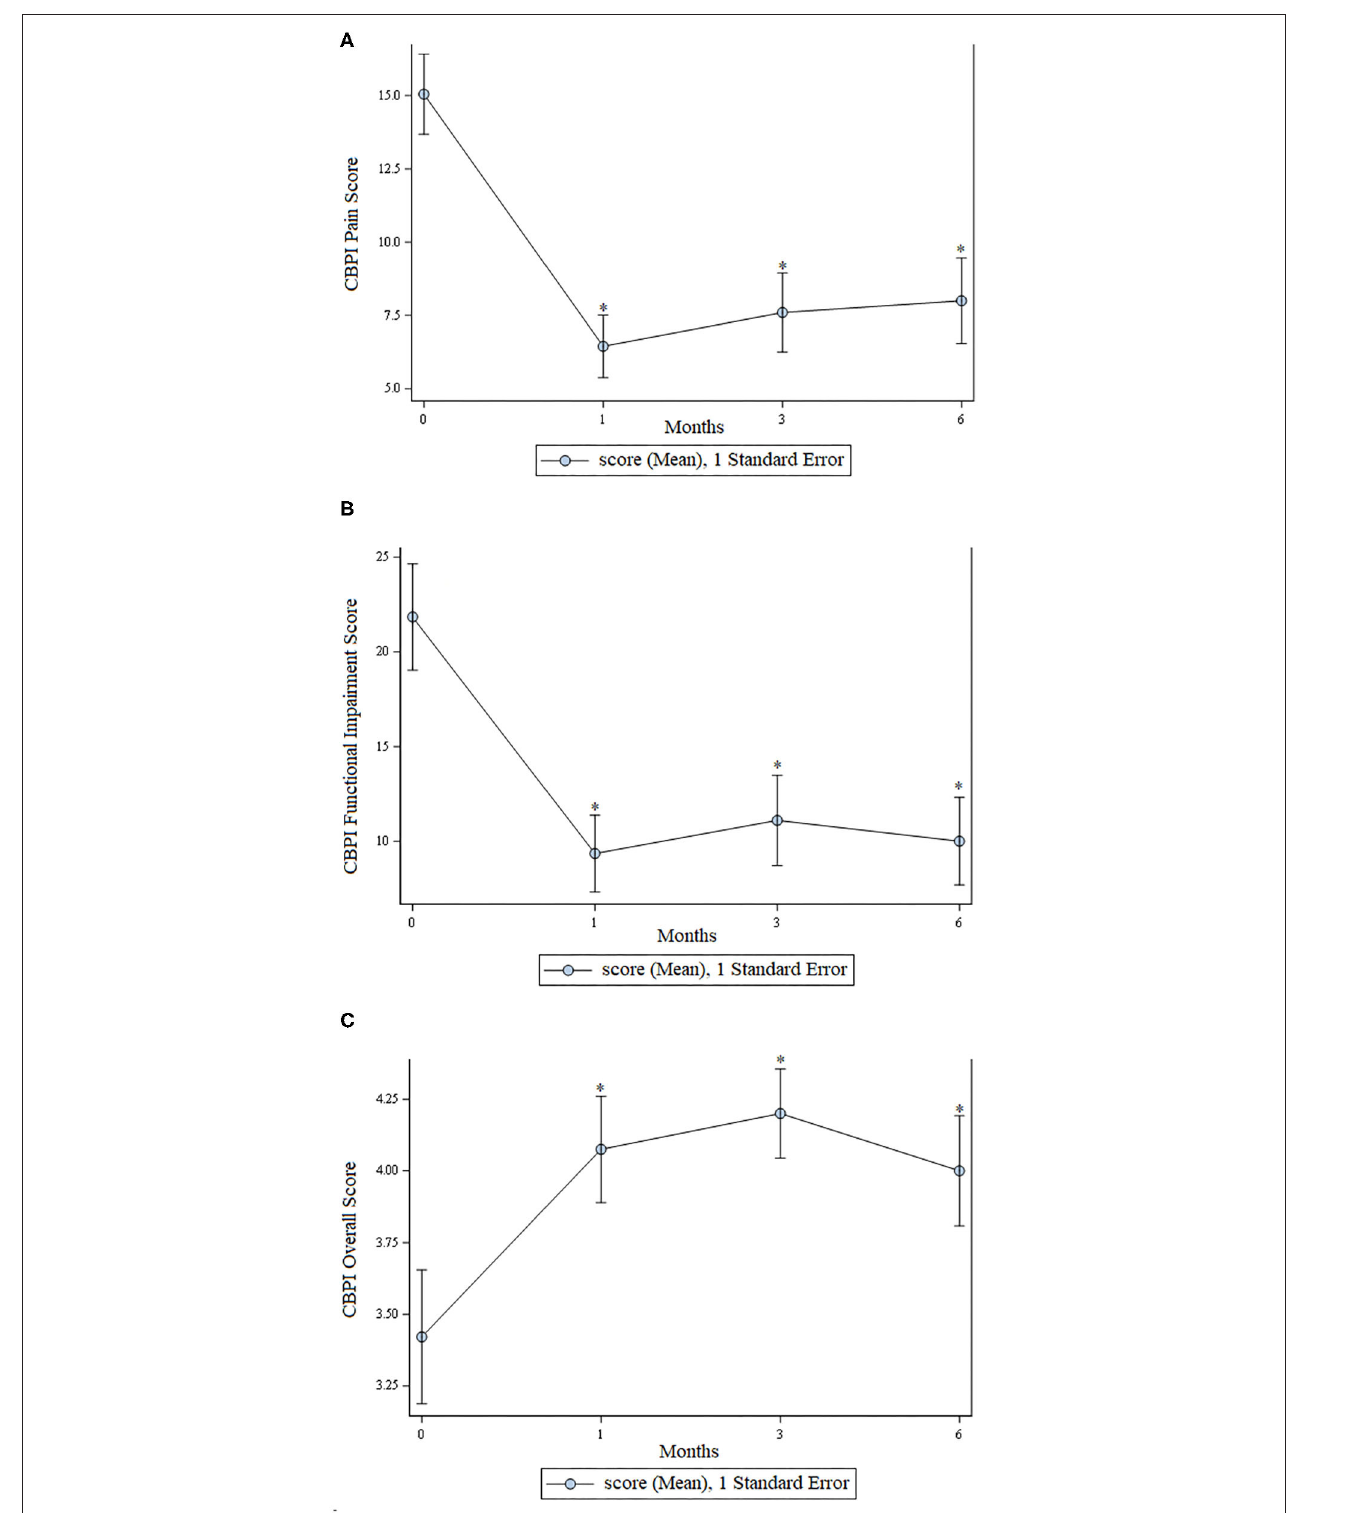
FIGURE 1 | Scores from the Canine Brief Pain Inventory. (A) Pain scores; lower scores indicate less pain. (B) Functional impairment; lower scores indicate less functional impairment. (C) Overall owner assessment; higher numbers are better. In all graphs an * indicates a significant ( p < 0.05) change from baseline.